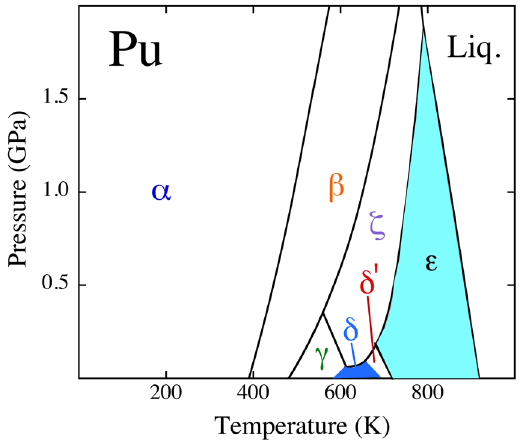
Figure 1. The experimental phase diagram for plutonium metal, redrawn after 20 .